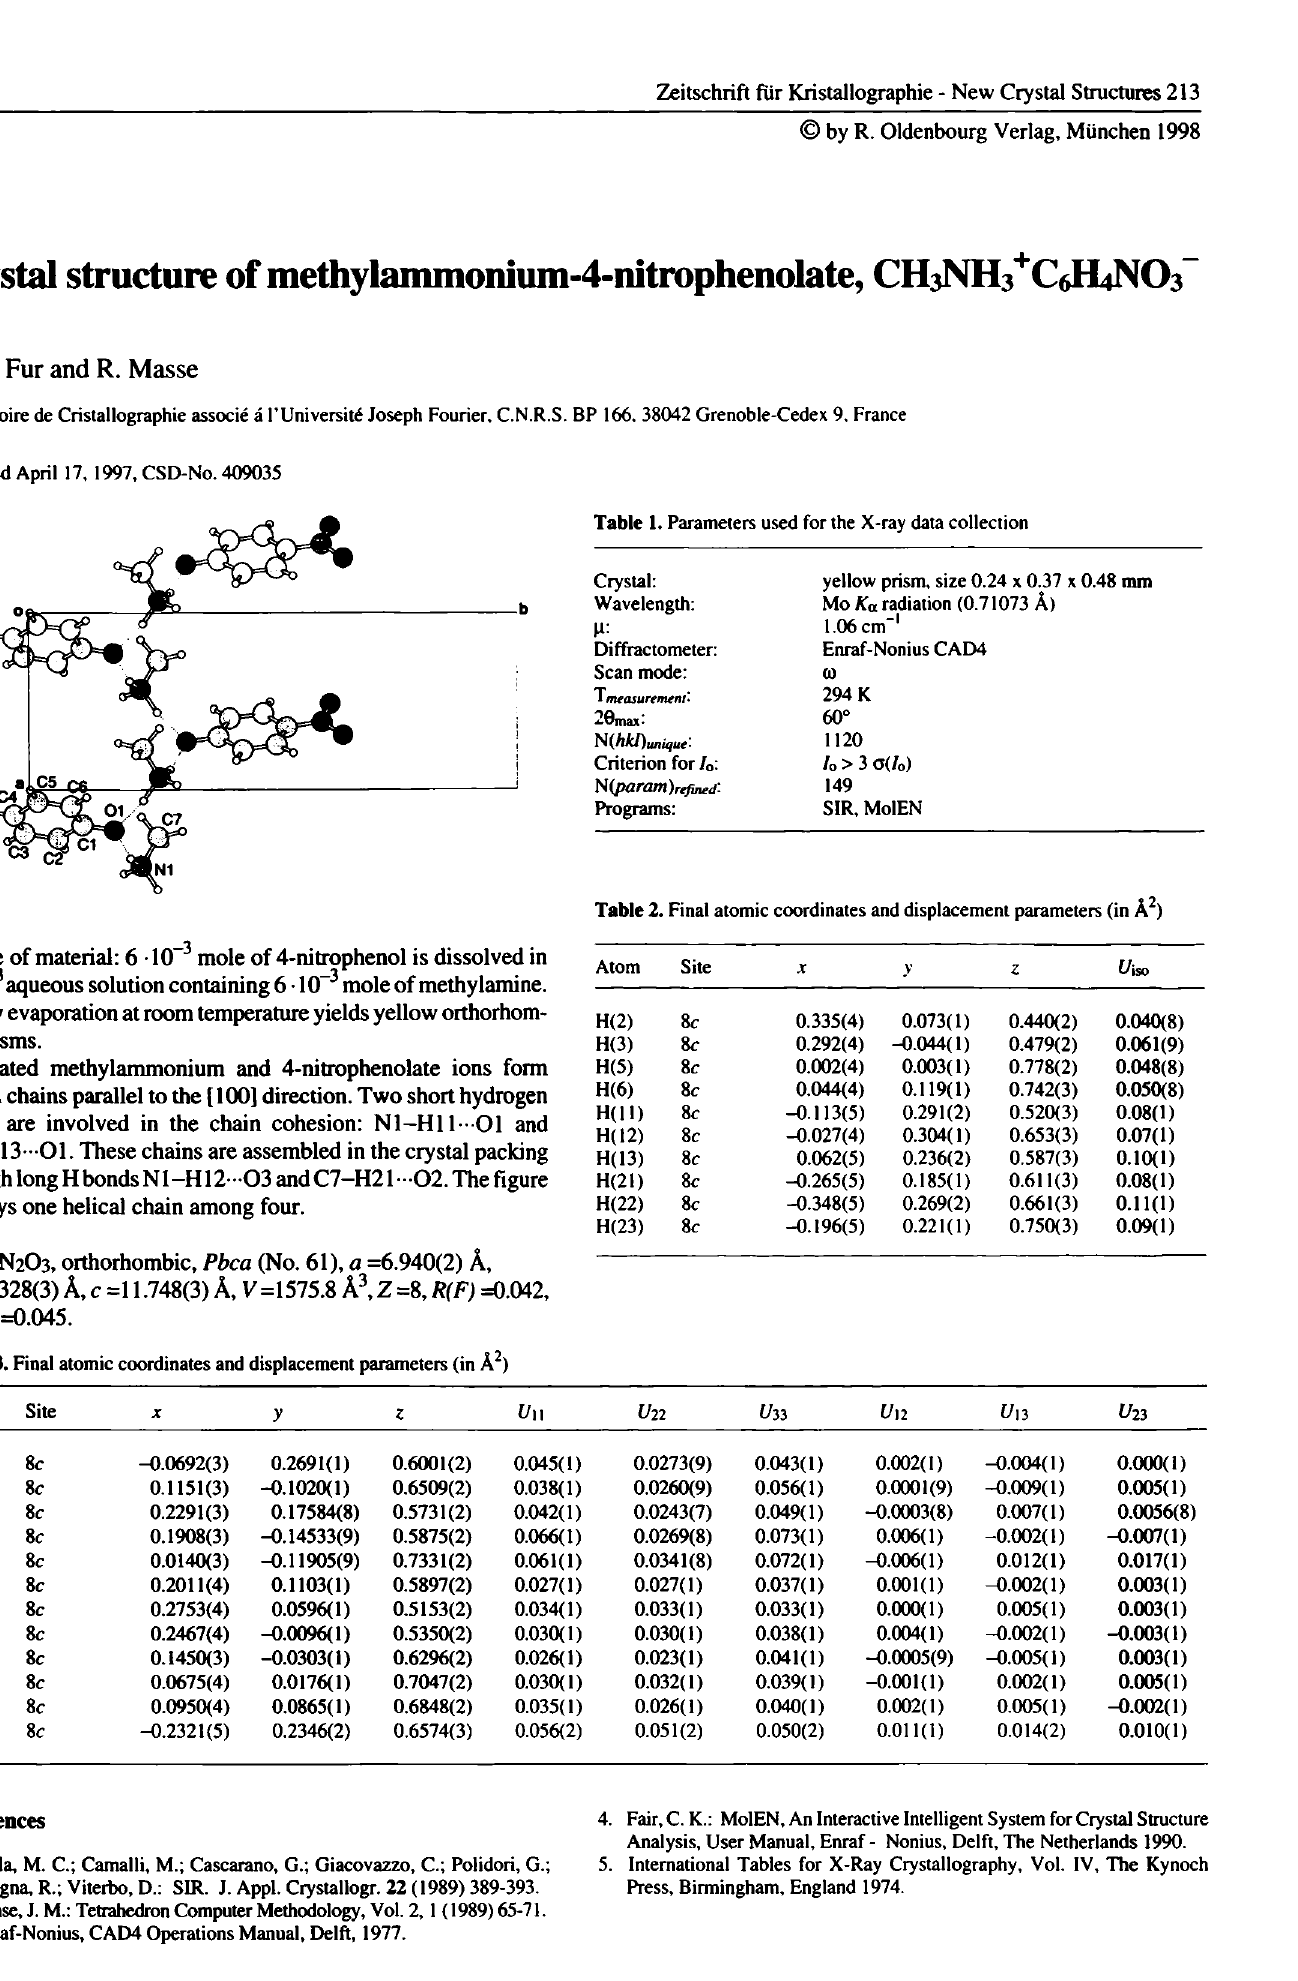
Table 3. Final atomic coordinates and displacement parameters (in